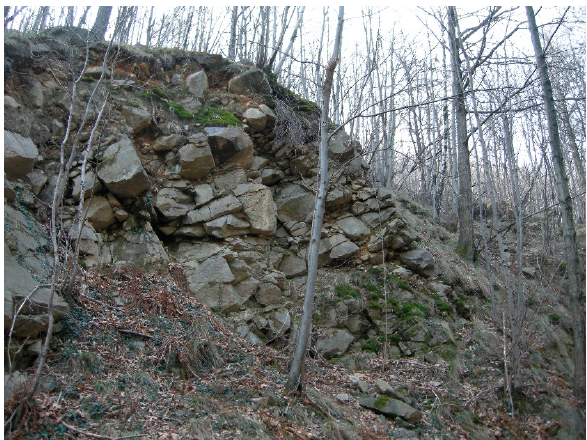
Figure 6. Loosened rocks outcropping in sector 2 characterized by high permeability due to fractures. Water 2019 , 11 , x FOR PEER REVIEW